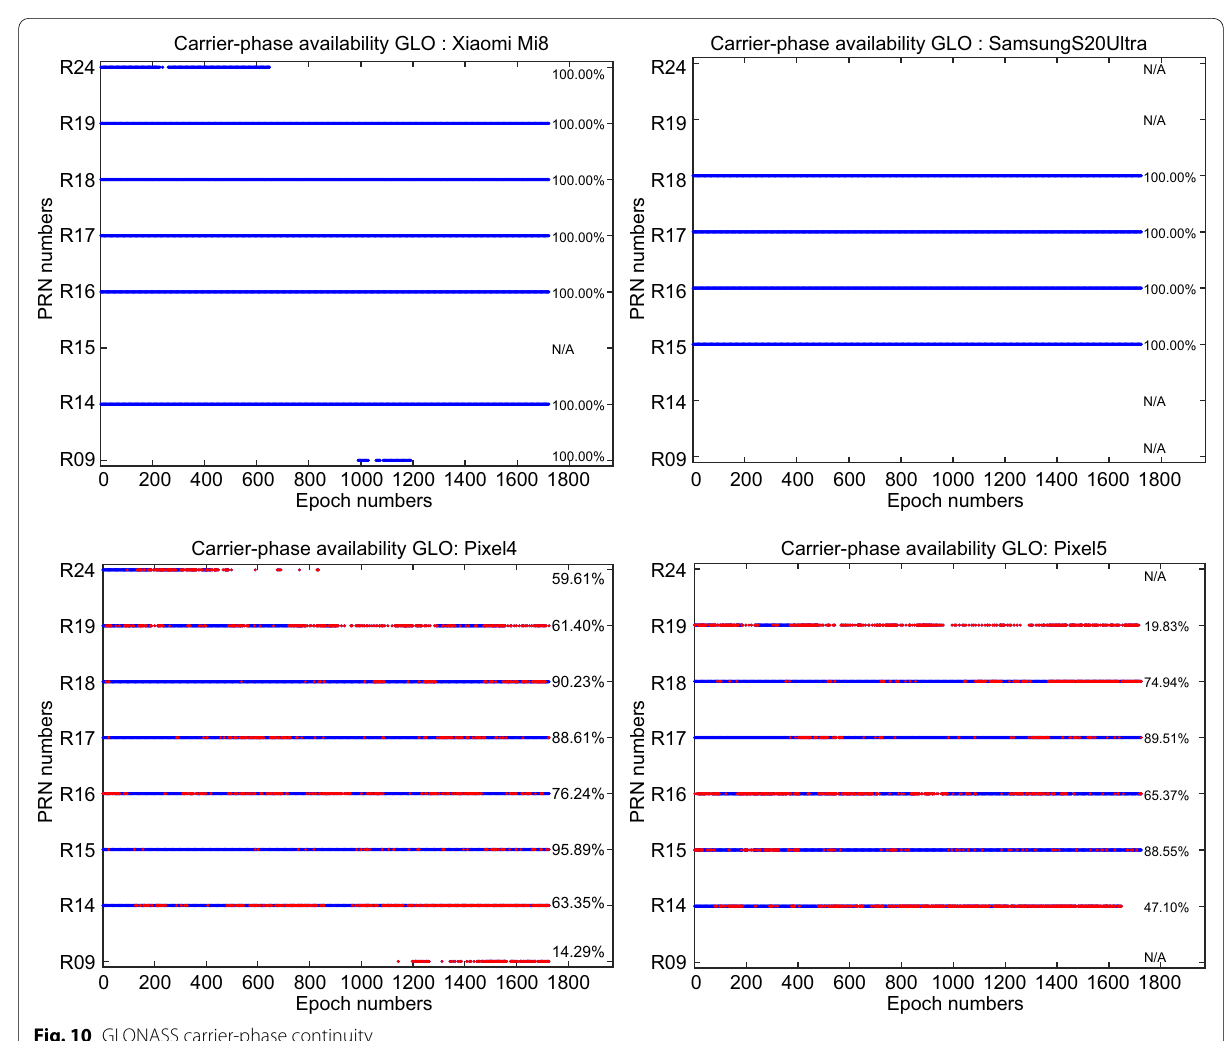
Fig. 10 GLONASS carrier-phase